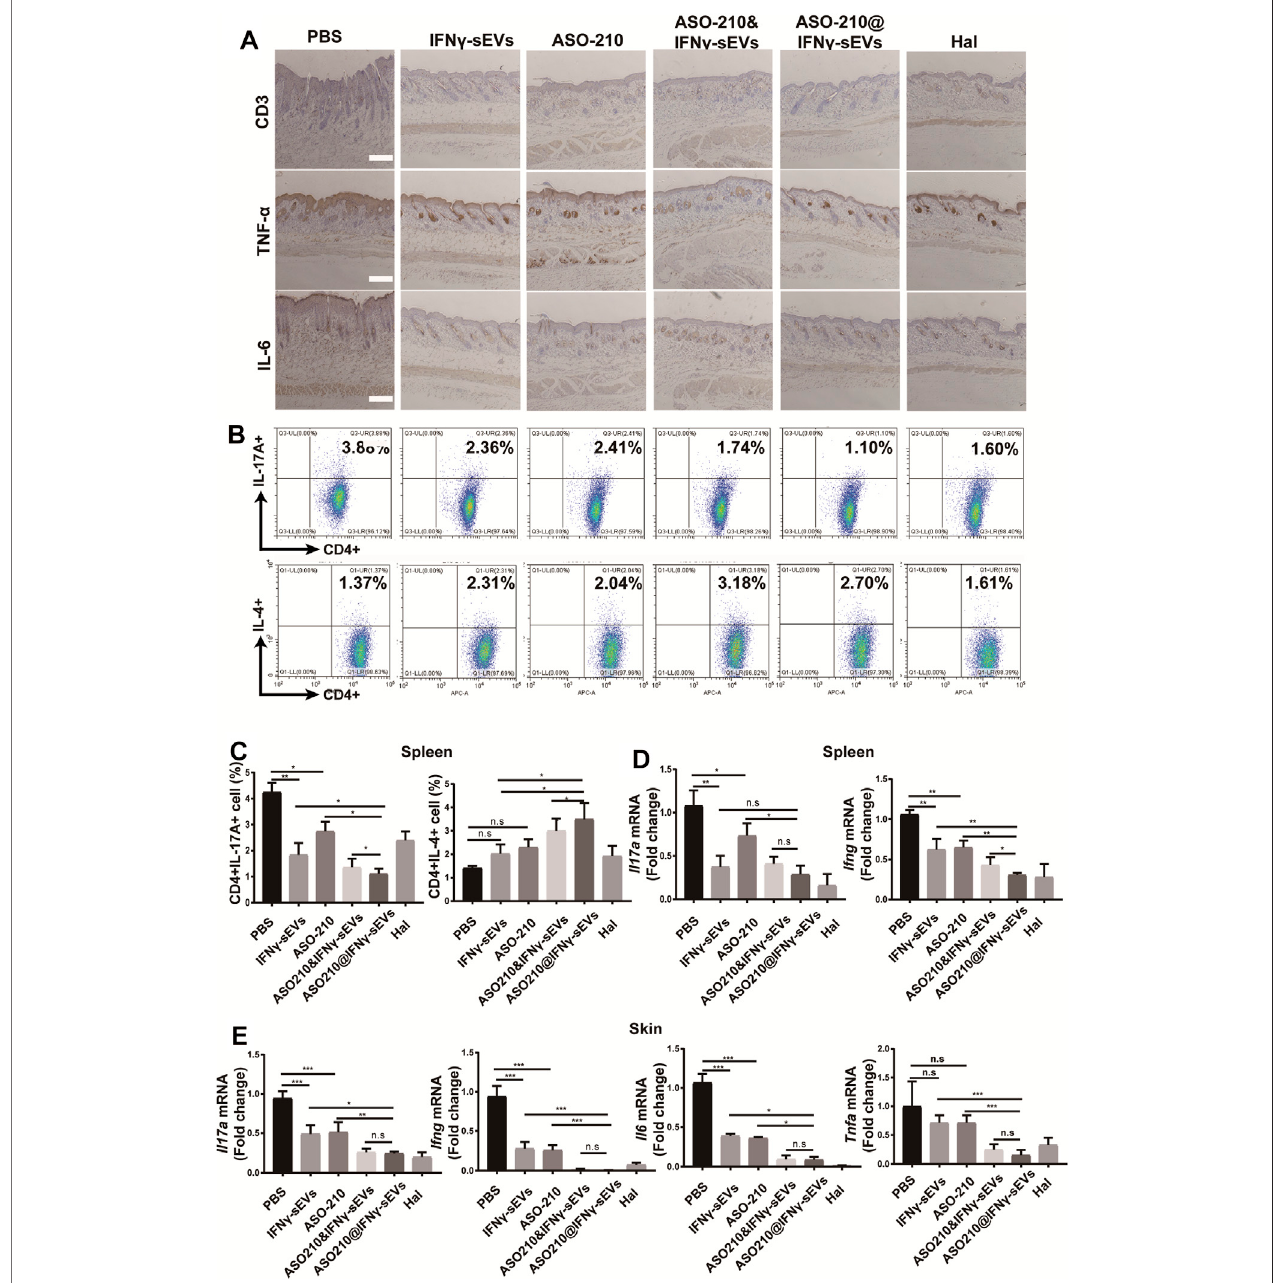
FIGURE4| IFN γ -sEVsexhaustTh17cellsandreducein fl ammatorycytokineexpressioninIMQ-inducedpsoriasis-likemice. (A) ImmunostainingofCD3,IL-6,TNF- α in skin lesion of the PBS, IFN γ -sEVs, ASO-210, IFN γ -sEVs&ASO-210, and ASO-210@IFN γ -sEVs and Halometasone groups on day 6. Scale bar, 200 μ m. (B,C) Representative fl ow cytometry analysis of Th17, and Th2 cells in splenic CD4 + T cells from different groups (n = 3). (D) qPCR analysis showed mRNA levels of Il17a and Ifng of the spleen section from different groups on day 6 (n = 3/4). (E) qPCR analysis showed mRNA levels of Il17a , Il6 , Ifng , and Tnfa of the skin section from different groups on day 6 (n = 3/4). Error bar, mean ± SD. n.s represents no signi fi cance, * p < 0.05, ** p < 0.01, and *** p < 0.001.